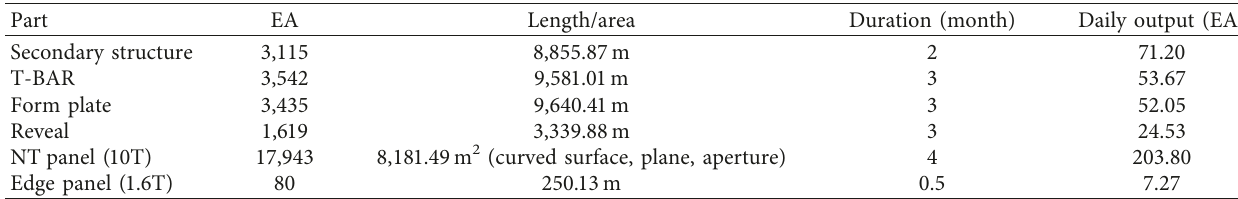
Figure 8: Fabrication model. Table 2: List of prefabricated components.